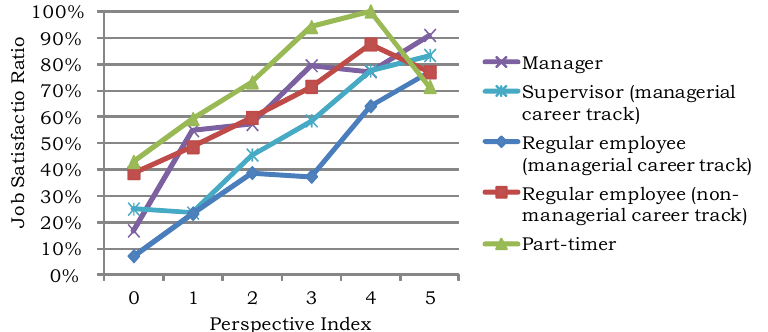
Figure 3. Perspective index and job satisfaction of each job type